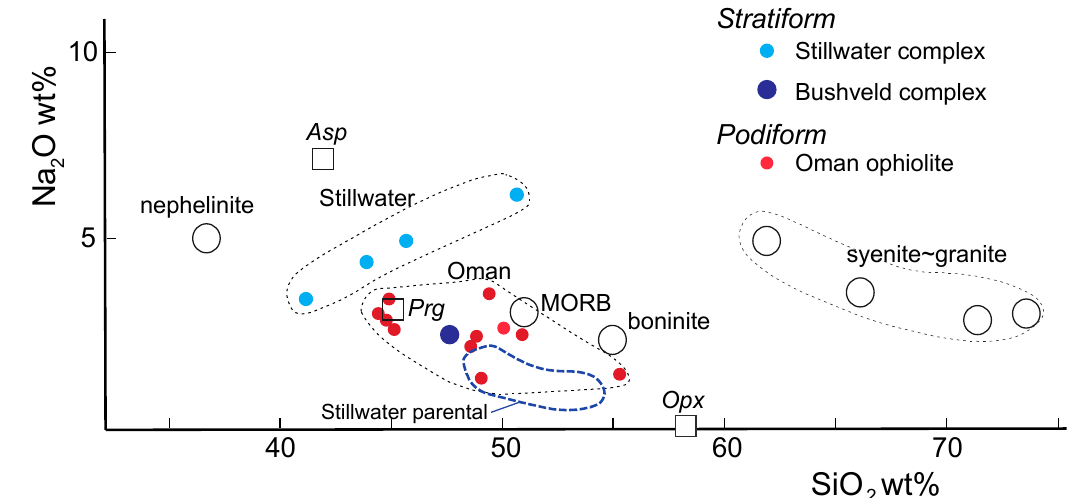
Figure 3. Na 2 O–SiO 2 relations of the bulk compositions of the chromite-hosted inclusions and some representative magmas. The bulk compositions of the chromite-hosted inclusions in the chromitites were determined by homogenization experiments for the Stillwater layered intrusion [13] and for the Oman ophiolite [47,55]. An averaged composition of inclusions was calculated for the Bushveld layered intrusion [52]. The compositions of a nephelinite [56], an averaged mid-ocean ridge basalt (MORB) [57], an averaged Hawaiian tholeiite (TH) [58], boninites [59] and granites–syenites [60] are shown for comparison. The range for possible parental magmas to the Stillwater complex [61] is also shown.